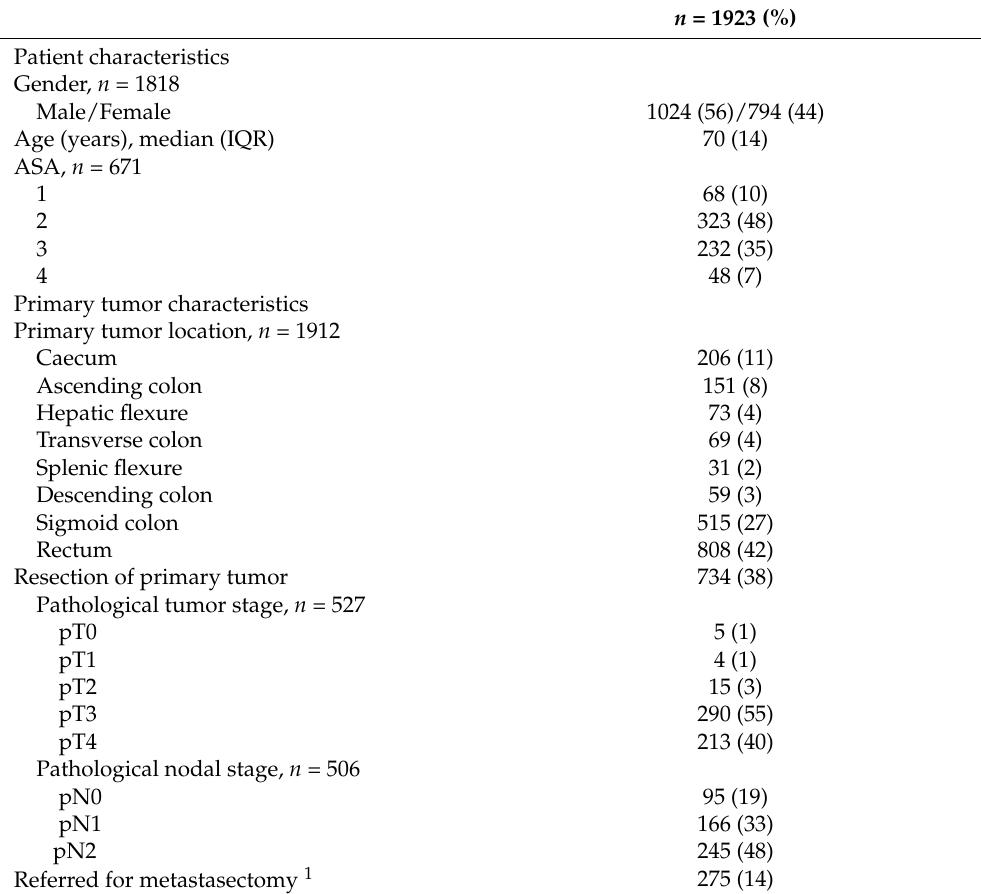
Table 1. Patient and tumor characteristics in 1923 patients with synchronously diagnosed liver and lung metastases from colorectal cancer.